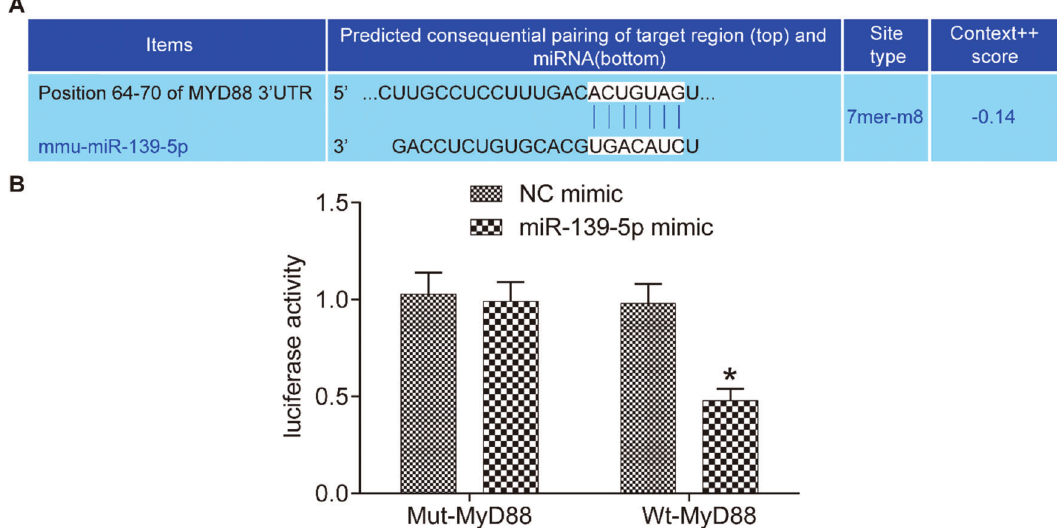
Figure 1 - miR-139-5p targets MyD88 gene expression. The 3 ’ -UTR region in which miR-139-5p binds to MyD88 (A); results of the dual luciferase reporter assay (B). The asterisk (*) indicates a significant difference compared with the NC group, where p o 0.05. MyD88, myeloid differentiation factor 88.